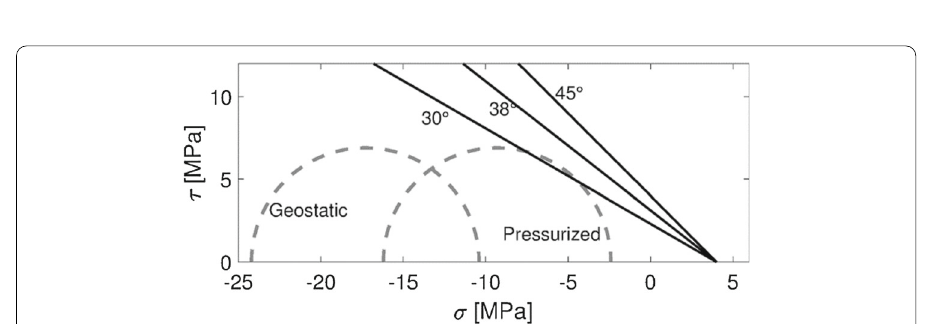
Fig. 7 Sensitivity analysis of the laboratory test simulation on the tensile strength. Gray circles: T c = 3 MPa. Black circles: T c = 4 MPa. White circles: T c = 5 MPa. a Fracture surface versus time. b Fracture surface closeup at the time of the formation of the first set of faults. c Fracture volume versus time. d Fracture volume closeup at the time of the formation of the first set of faults